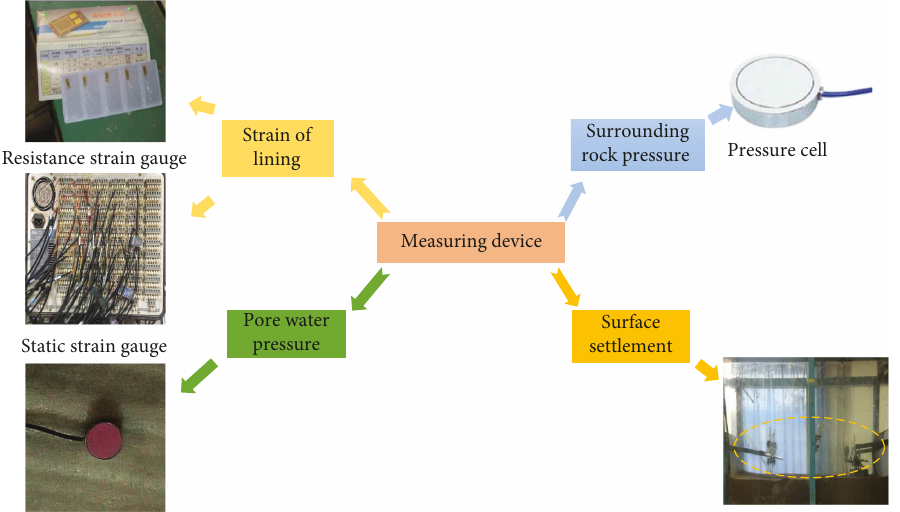
Figure 4: Measuring